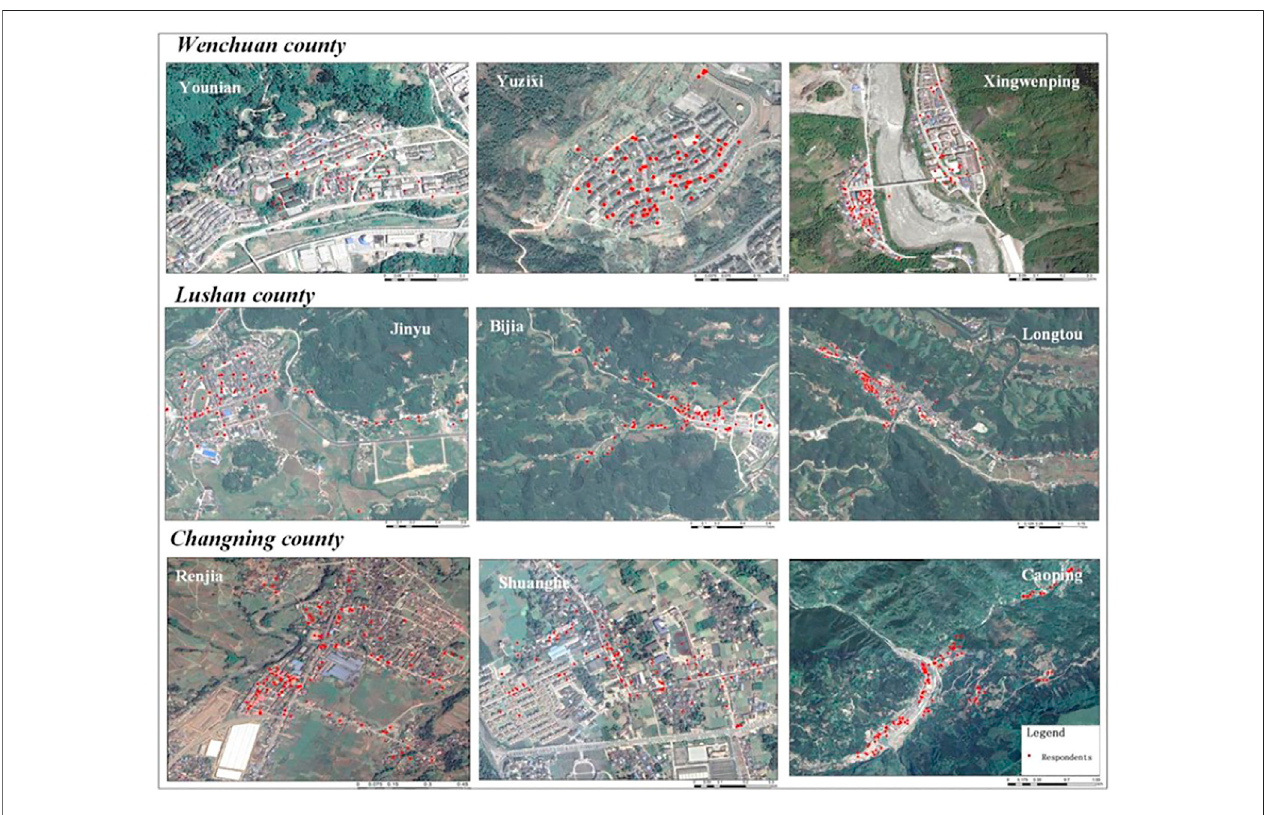
FIGURE 2 | Spatial distribution of respondents.